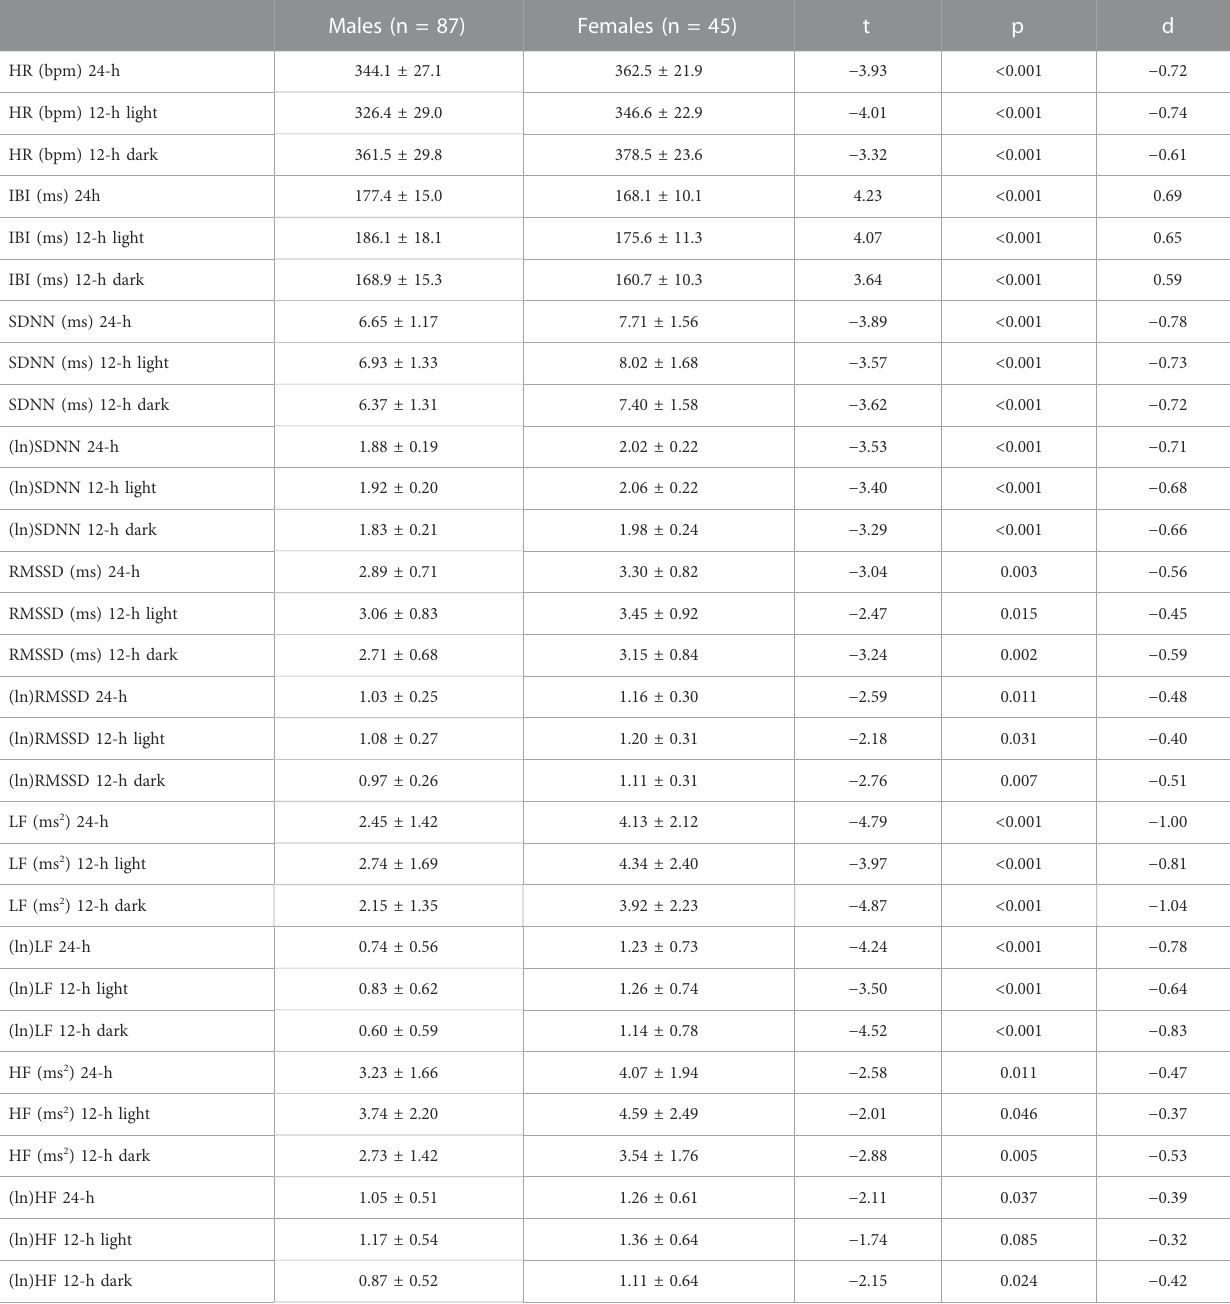
TABLE 1 Mean differences between male and female rats on 24-h values and on 12-h values for the light (inactive) and dark (active) phases of the daily